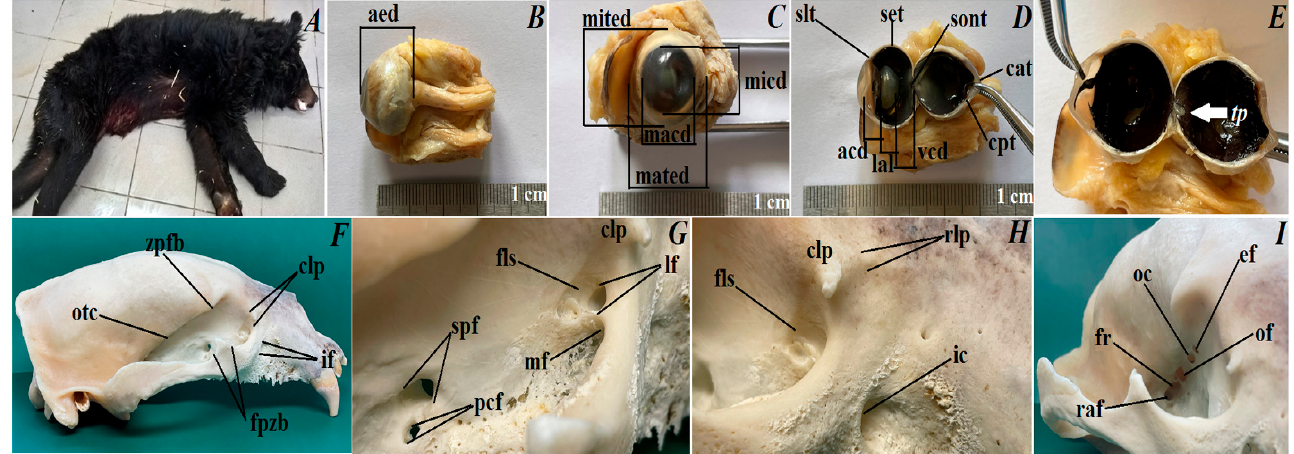
Figure 1. The macrograph of the adult male Ursus thibetanus ( A ); dimensions of the eyeball ( B – D ); tapetum lucidum ( E ); skull ( F ); orbital anatomy ( F – I ). acd—aqueous chamber depth, aed—axial eye diameter, cat—corneal (axial) thickness, clp—caudal lacrimal process, cpt—corneal (peripheral) thickness, ead—axial eye diameter, ef—ethmoid foramen, fls—fossa for the lacrimal sac, fpzb—frontal process of the zygomatic bone, fr—foramen rotundum, ic—infraorbital canal, if—infraorbital foramen, lal—lens axial length, lf—lacrimal foramen, macd—maximum corneal diameter, mated—maximum transverse eye diameter, mf—maxillary foramen, micd—clpminimum corneal diameter, mited—minimum transverse eye diameter, oc—optic canal, of—orbital fissure, otc—orbitotemporal crest, pcf—palatine caudal foramen, raf—rostral alar foramen, rlp—rostral lacrimal process, set—scleral (equator) thickness, slt—scleral (limbus) thickness, sont—scleral (optic nerve) thickness, spf—sphenopalatine foramen, tp—tapetum lucidum (white arrow), vcd—vitreous chamber depth, zpfb—zygomatic process of the frontal bone.